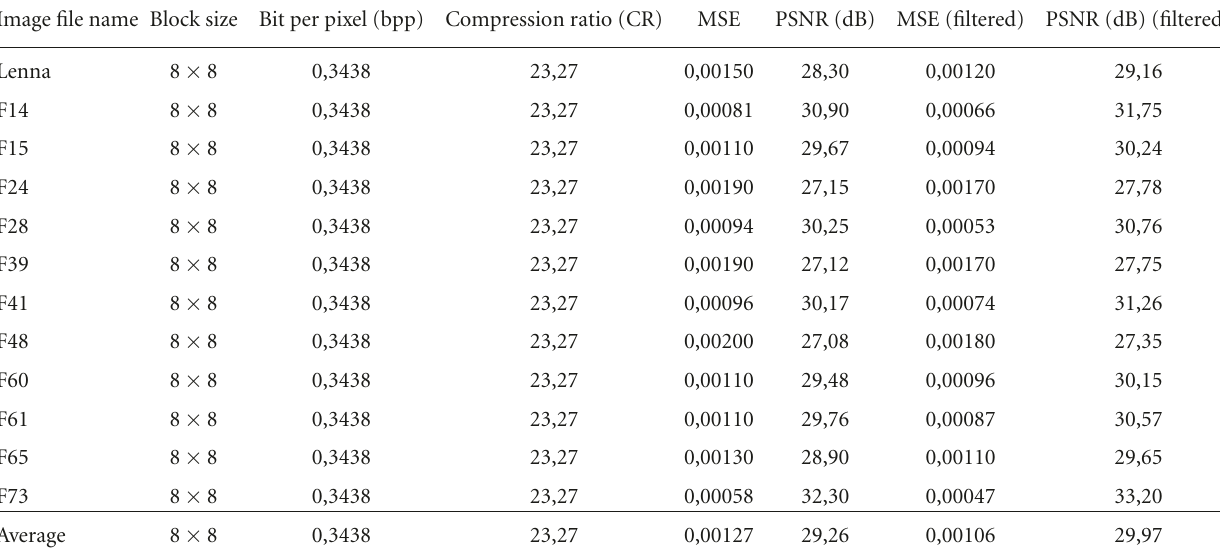
Table 8: Evaluation results of Fold 3 (with